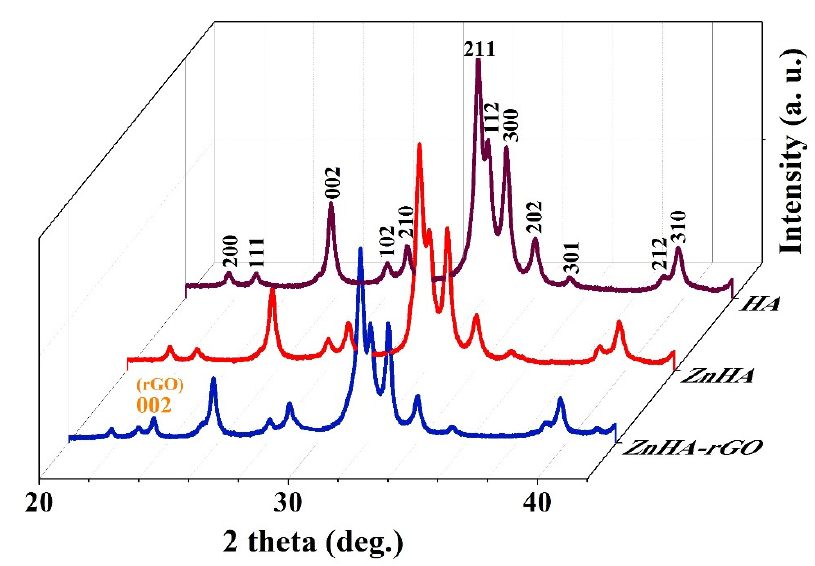
Figure 2. XRD patterns of HA, ZnHA, and ZnHA-rGO nanoparticles. The diffraction pattern of HA nanoparticles was well in accordance with the standard pattern of HA (JCPDS card No. 09– 0432); hexagonal structure. The XRD patterns of ZnHA and ZnHA-rGO nanoparticles were highly similar to that of HA nanoparticles. A peak corresponding to graphene nanosheets (002) was seen in ZnHA-rGO.